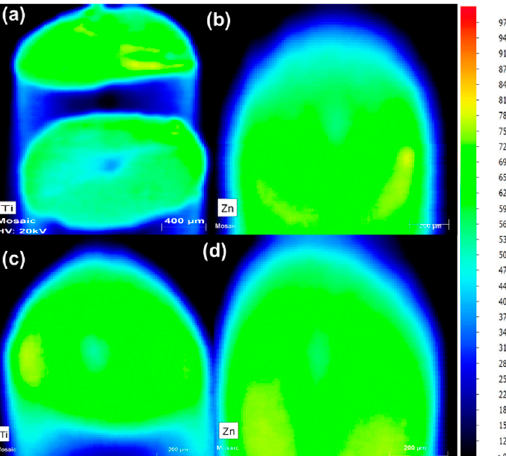
Figure 4. MXRF color mapping of: ( a ) Ti in PLA/TiO 2 90/10; ( b ) Zn in PLA/ZnO 90/10; ( c ) Ti in PLA/TiO 2 /PEG2k 80/10/10; and ( d ) Zn in PLA/ZnO/PEG2k 80/10/10. Increasing amounts of the indicated element are colored from blue to green to red.